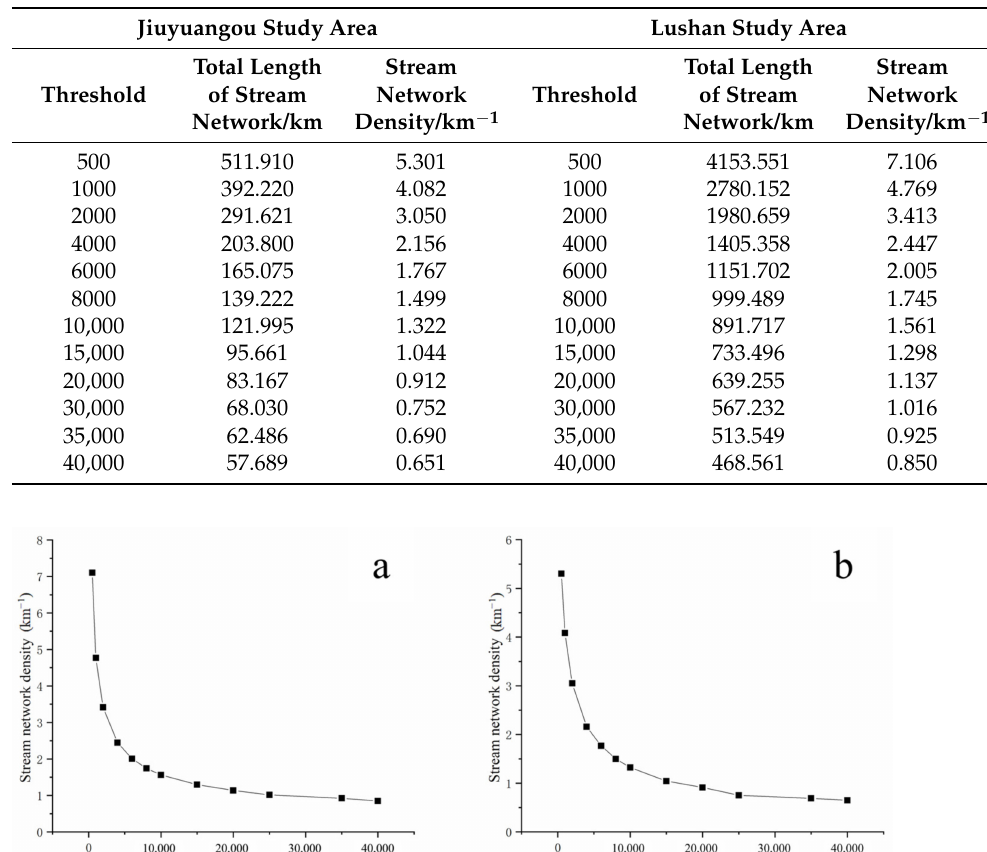
Table 3. Calculation of the density of the stream network.